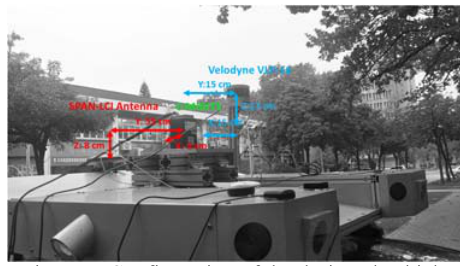
Figure 5. Configuration of the designed vehicle